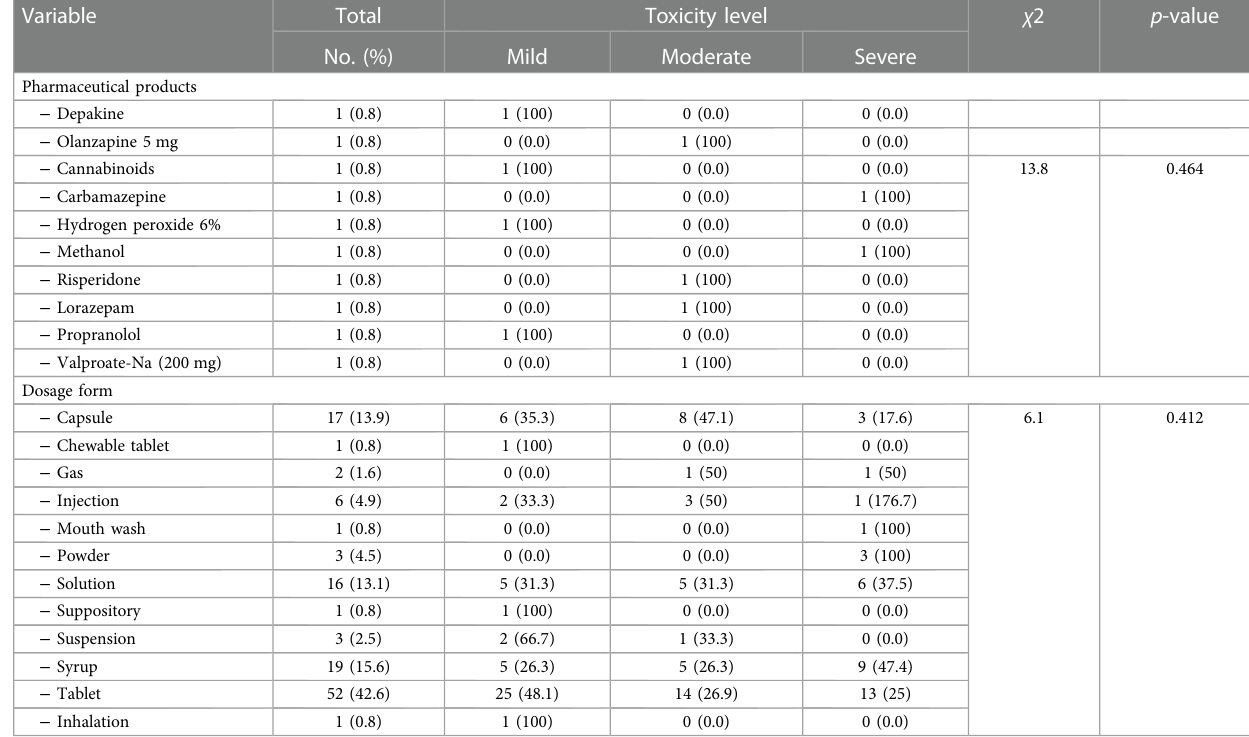
TABLE 1 Relationship between pharmaceutical products and the level of toxicity.